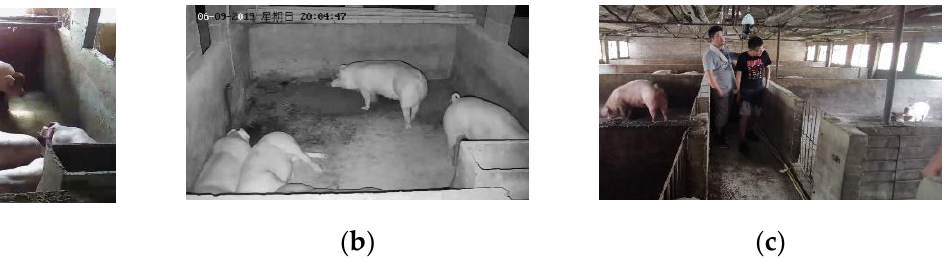
Figure 1. Video capture scene: ( a ) piggery during the day; ( b ) another piggery at night; ( c ) camera position.